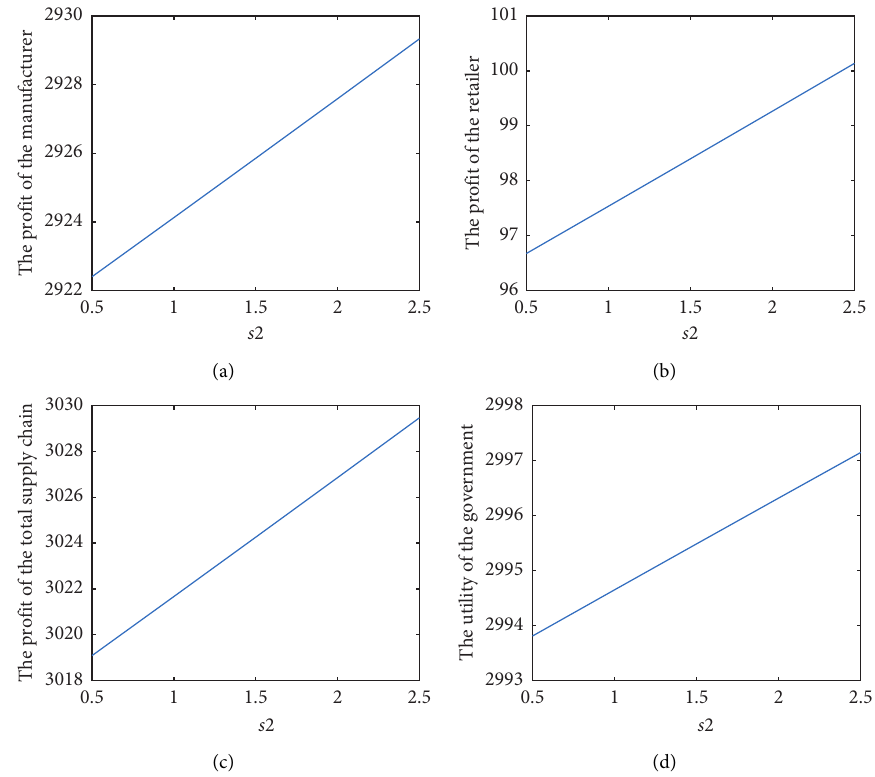
Figure 9: The effect of the government’s subsidy coefficient to the retailer s